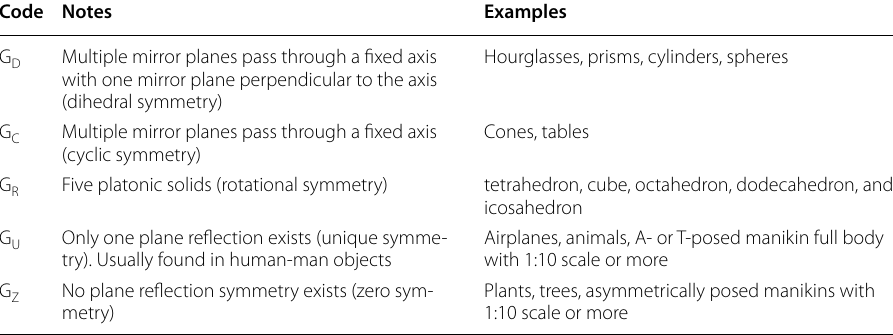
Table 1 Classes of shape symmetry. Modified from (Dubrovin et al., 1984) and (Chaouch & Verroust- Blondet, 2009)